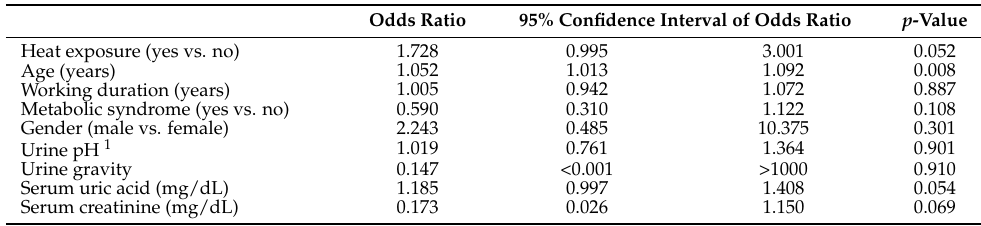
Table 3. Logistic regression of radiolucent stones predicted by age, working duration, metabolic syndrome, gender, heat exposure, urine pH, urine gravity, serum uric acid, and creatinine. Odds